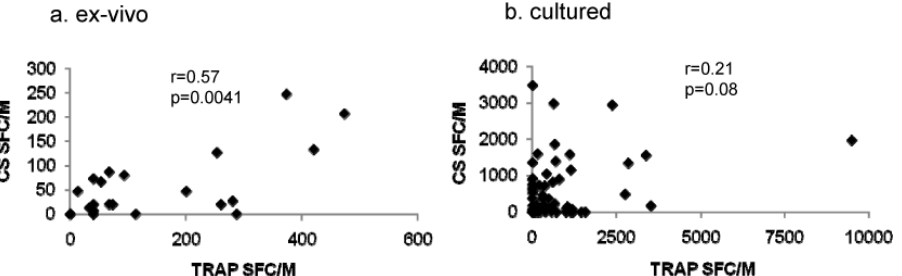
Figure 2. Correlations between ELISPOT responses. The relationship was examined between (a) TRAP and CS responses both ex-vivo, and (b) TRAP and CS responses both cultured.